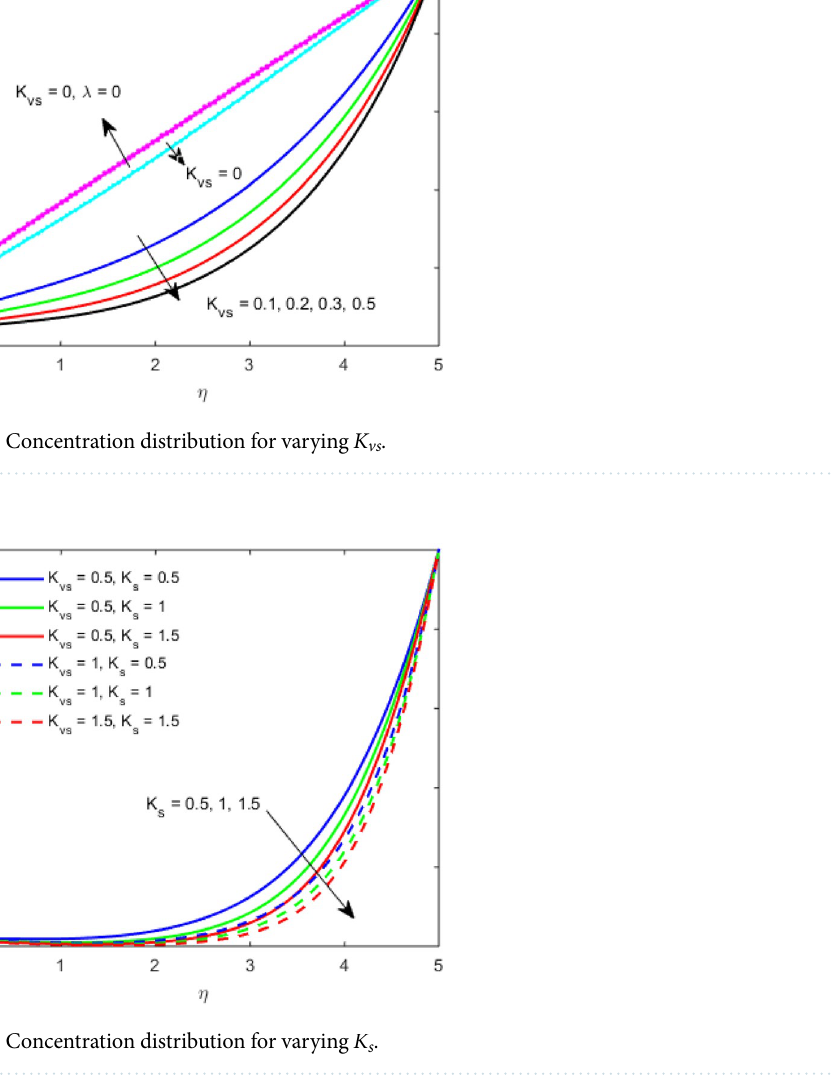
visualized that the presence of surface catalyzed reaction promotes the consumption of reactant species. Figure 5 represents the coefficient of drag force versus the velocity slip parameter for escalating values of the porosity parameter. The graphical analysis of the coefficient of drag force indicates that the negligible decline occurs for increasing the porosity parameter. Surface catalysis on porous medium enhances the resistive forces which reduce the fluid motion. At the maximum value of the slip parameter, the coefficient of drag force is maximum. Figure 6 is drawn for the coefficient of drag force versus velocity slip parameter for increasing the magnetic moment parameter. It is witnessed that the coefficient of drag force in radial direction declines negligibly as the magnetic moment parameter increase because the presence of the magnetic field decreases the momentum boundary layer thickness due to Lorentz force. Figure 7 is the graphical depiction of coefficients of drag force in tangential direction versus velocity slip parameter for increasing Forchheimer number. Physically increasing slip parameter and inertia coefficient causes the decrease in momentum boundary layer thickness along with velocity profiles. Increasing F r means the increase in inertial coefficients resulting in a decline in drag force coef- ficients. Figure 8 signifies the variation of wall concentration versus K vs for increasing heterogeneous reaction parameter K s and. A declining trend is observed in wall concentration. Figure 9 shows that by keeping η fixed and increasing the value of the HET parameter, the concentration profiles versus HOM parameter declines. As the reaction proceeds and the reactants consume causes a decline in the concentration distribution at the wall. Figures 10 and 11 exhibit that the heat transfer rate versus thermal slip parameter for escalating values of the Brownian diffusion coefficient and thermophoresis parameter. Physically, increasing the Brownian motion parameter causes the irregular movements of nanoparticle which enhances the collision among particles. An increase in thermophoresis parameter value causes a thicker thermal boundary layer. Therefore, by increasing N t results the movement of particles from the region of higher temperature to the region of lower temperature.